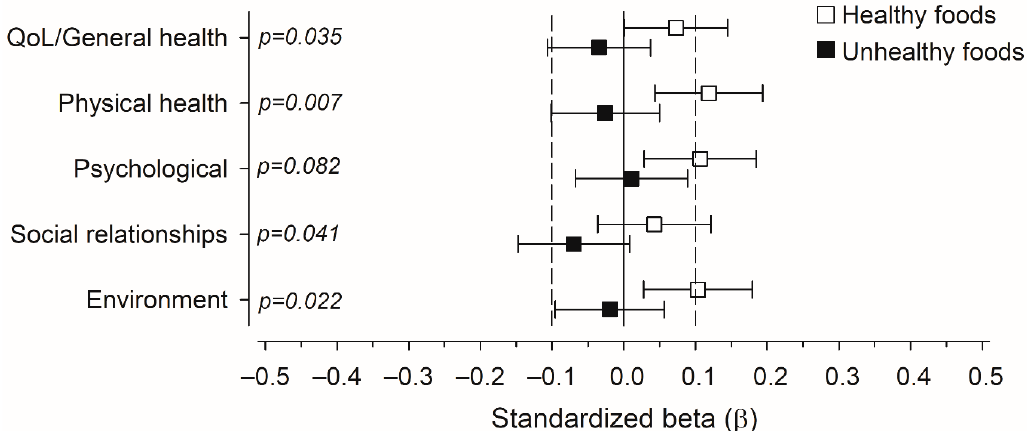
Figure 3. Relationships between consumption of (healthy and unhealthy) food items and different dimensions of quality of life (QoL) in a multivariate linear regression analysis with standardised regression coefficient beta ( β ). p -values are for the difference between the effect of healthy and unhealthy foods consumption. The models were adjusted for age, body mass index, education years, number of chronic diseases, smoking, and physical activity. Whiskers represent 95% confidence intervals.